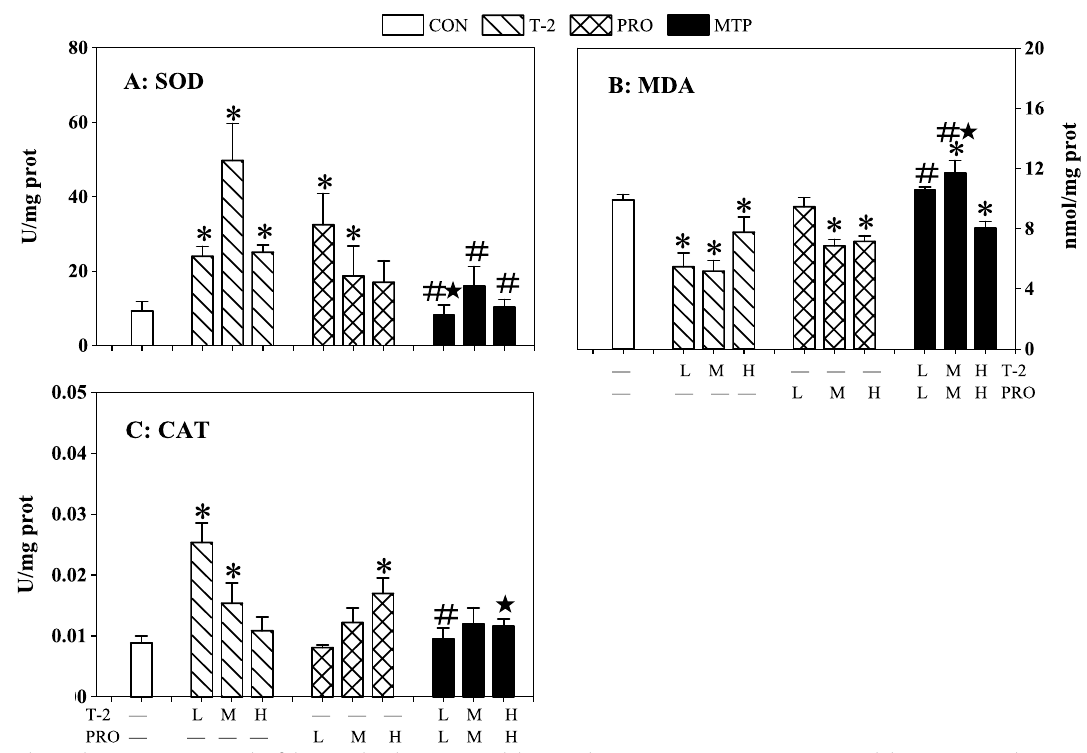
Fig. 1 The oxidative responses in zebrafish treated with T-2 PRO and their combinations. A SOD, B MDA, C CAT. Each bar represents the mean standard deviation ( n three replicates consisting of a group of 250 fish). * p < 0.05 substantial alteration by comparison with the control; ± = # p < 0.05 significant difference relative to the corresponding T-2 exposure; ★ p < 0.05 significant difference relative to the corresponding PRO exposure. CON control, T-2 T-2 toxin, PRO propiconazole, MTP the mixture of T-2 and PRO. L low concentration; M middle concentration, H high